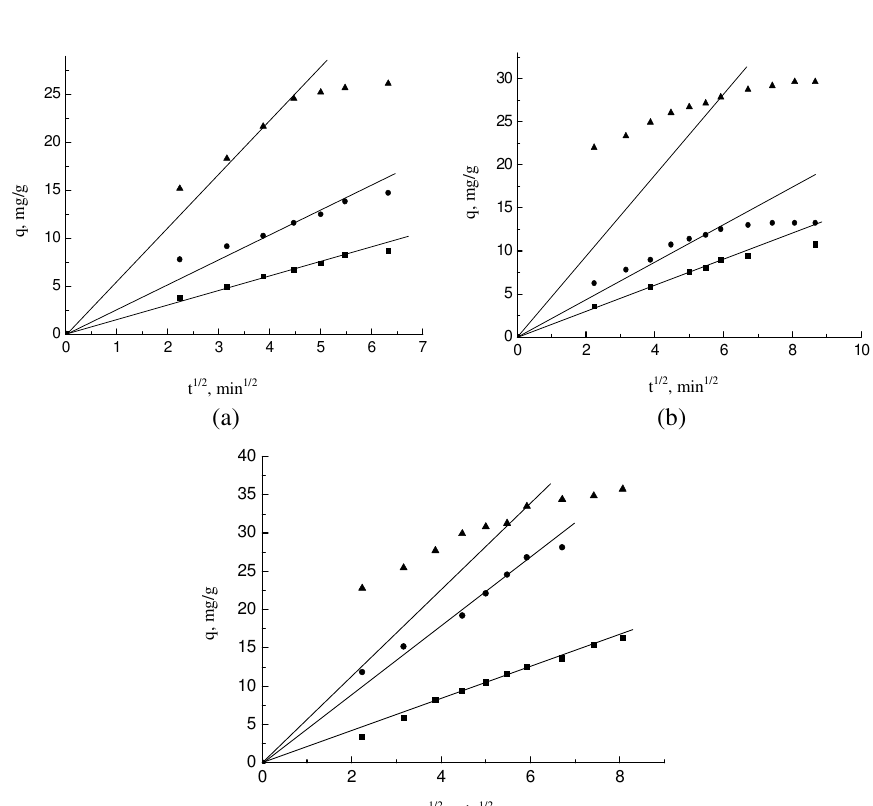
Figure 9. Plot of q vs . t 1/2 in internal diffusion model of PEG (20000). (a) 300 mg/L, (b) 500 mg/lL, (C) 700 mg/L; ( ■ ) 5 °C, ( ● ) 25 °C, ( ▲ ) 45